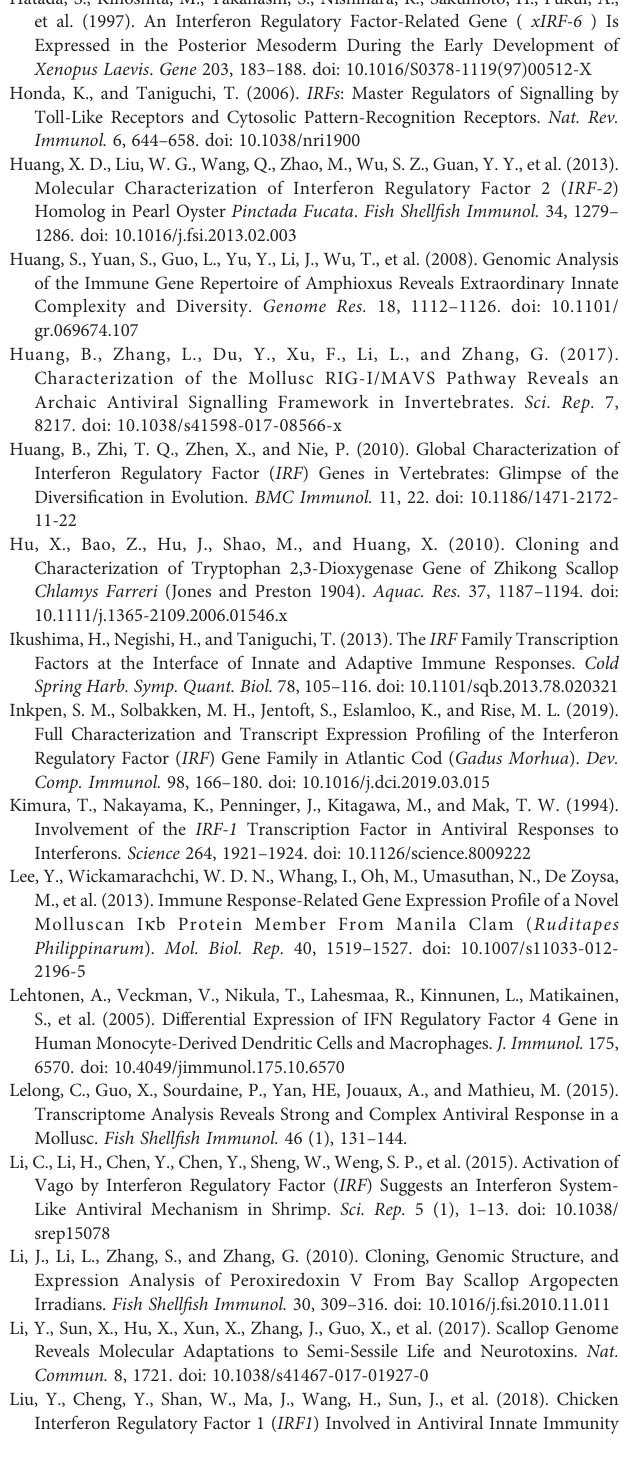
represent the mean ± S.E. (N=3). P values are calculated by one-way analysis of variance (ANOVA) in SPSS software. Different letters indicate signi fi cant differences (P <